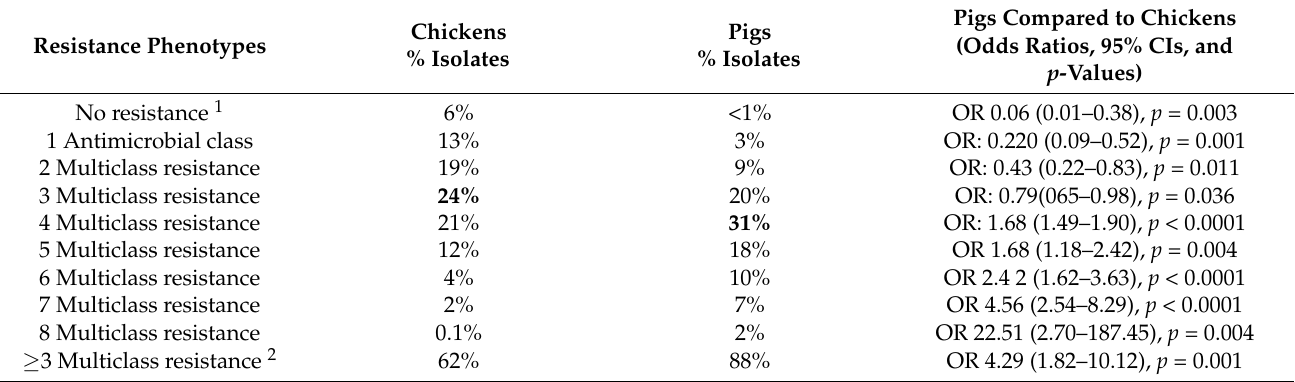
Figure 4. Distribution of the resistance phenotypes (number of individual antimicrobials in the pattern) in Escherichia coli from chickens (depicted by the green bars; n = 1110) and in pigs (depicted by the blue bars; n = 754) ( A ), and the distribution of resistant phenotypes (number of classes in the pattern) in chickens ( B ) and pigs ( C ). Please refer to the Supplementary Materials, Table S2A,B, for the specific antimicrobial resistance phenotypes. Table 2. Antimicrobial resistance phenotypes in Escherichia coli from chickens ( n = 1110) and pigs ( n = 754) in the Lao PDR, 2018–2021, and comparison of the differences in percentages between pigs (referent species) and